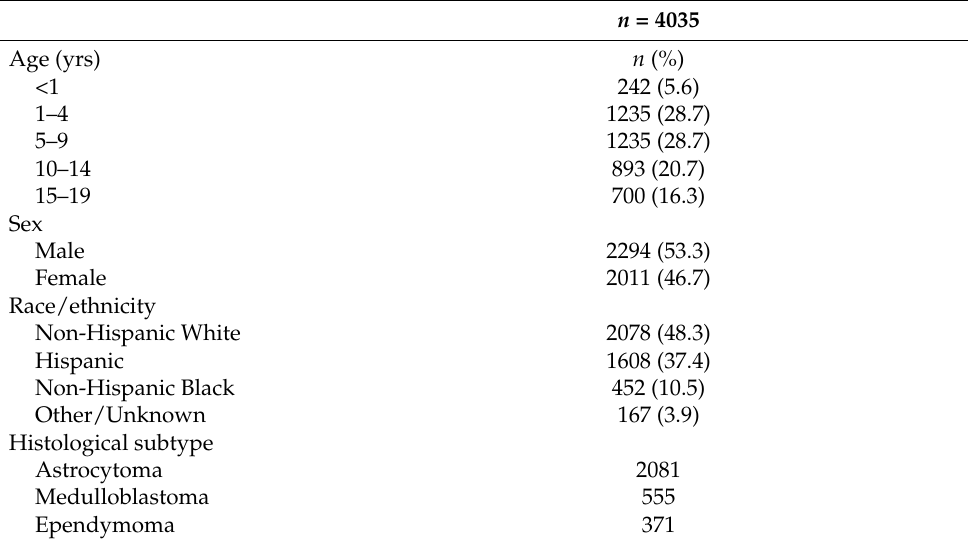
Table 1. Characteristics of children diagnosed with pediatric brain tumor, Texas, 2000–2017.